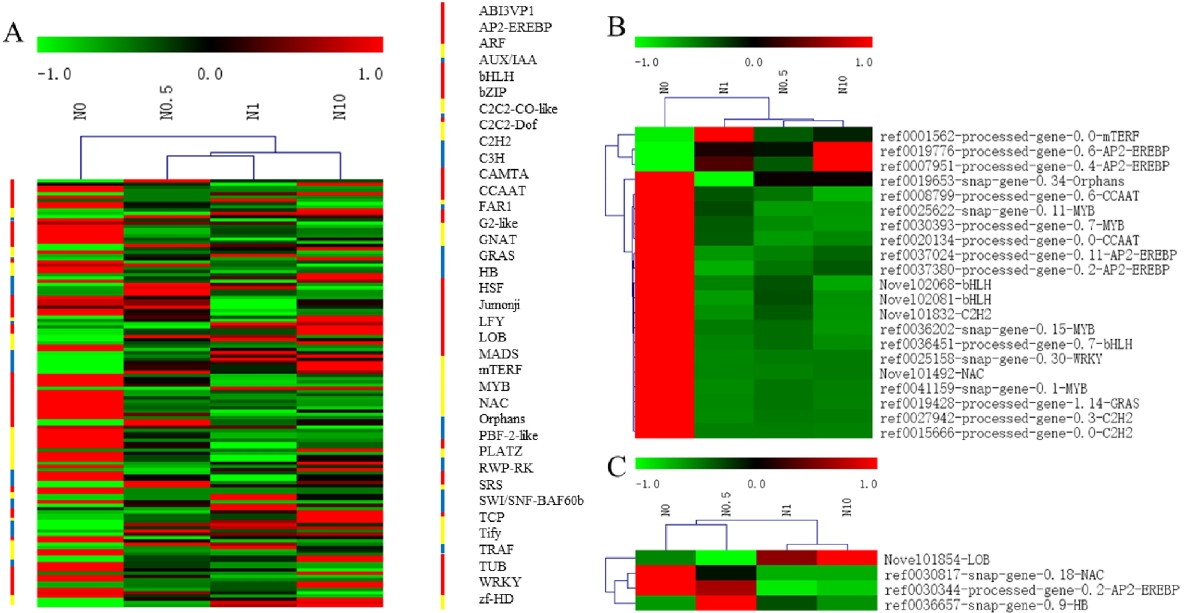
Figure 10. Heat map clustering analysis of TFs related to nitrogen, nitrogen utilization and excessive nitrogen stress. ( A ) represents the clustering of TFs responses to nitrogen in perennial ryegrass. ( B ) represents the clustering of TFs related to nitrogen utilization. ( C ) represents the clustering of TFs related to excessive nitrogen stress. The coloured columns indicate the different TF families, and their lengths indicate the number of TFs. High-expression genes are shown in red, and low-expression genes are shown in